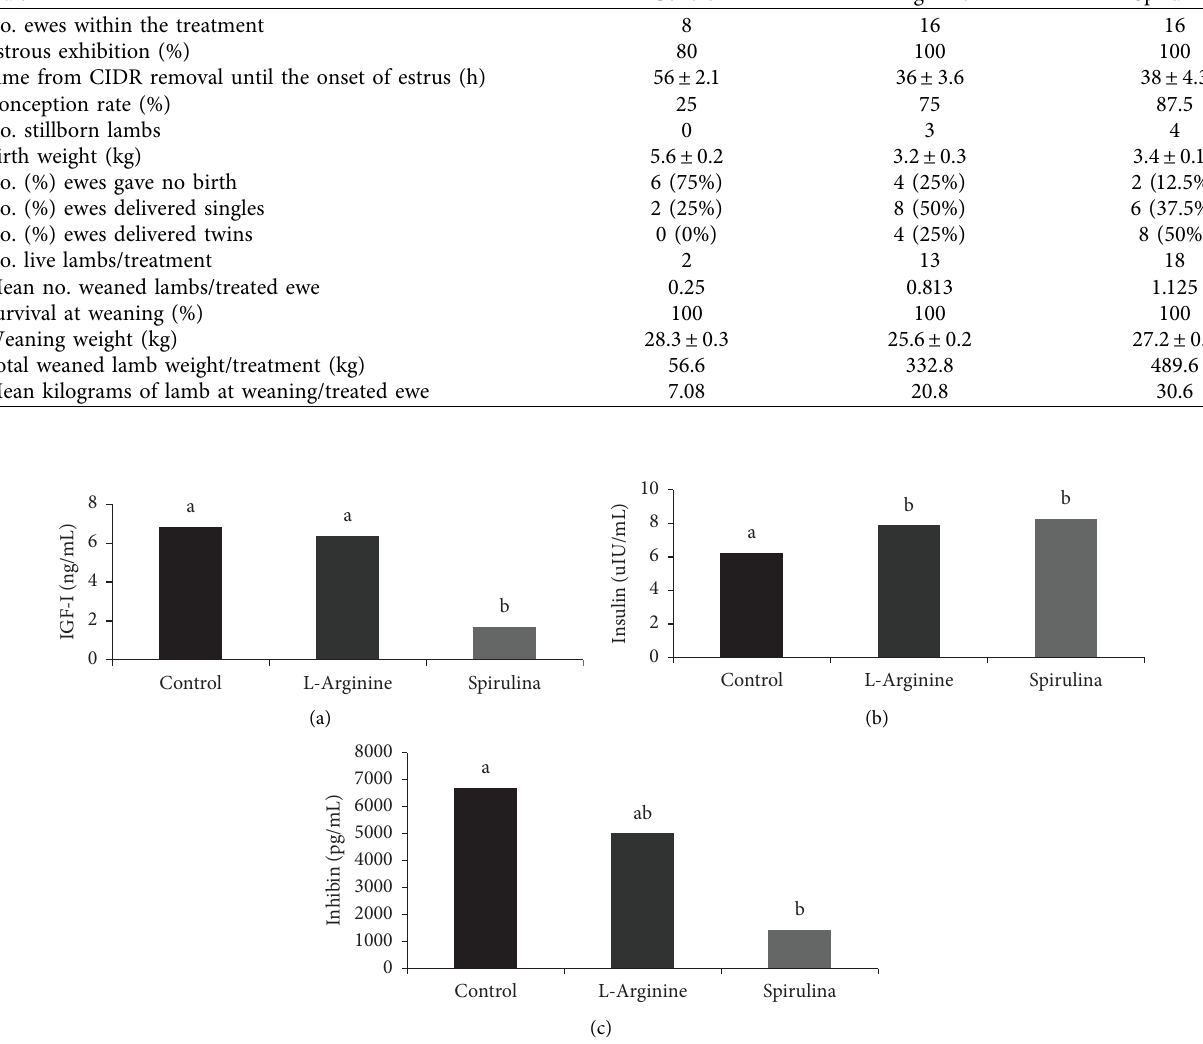
Table 1: Efect of supplementation of L-Arginine and Spirulina on the reproductive traits of Najdi and Noemi ewes induced for twinning. Trait